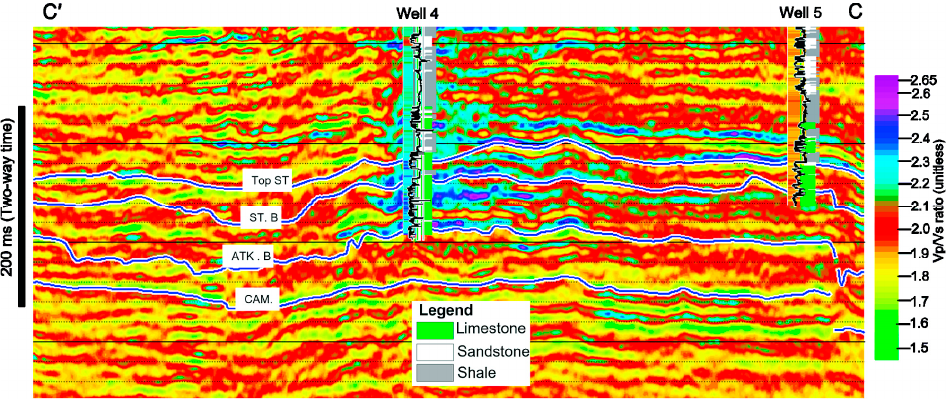
Figure 14. Cross section C–C ′ of inverted Vp/Vs-ratio volumes and passing through wells 4 and 5. Note: all inserted logs and abbreviated horizons names as defined in Figure 8.